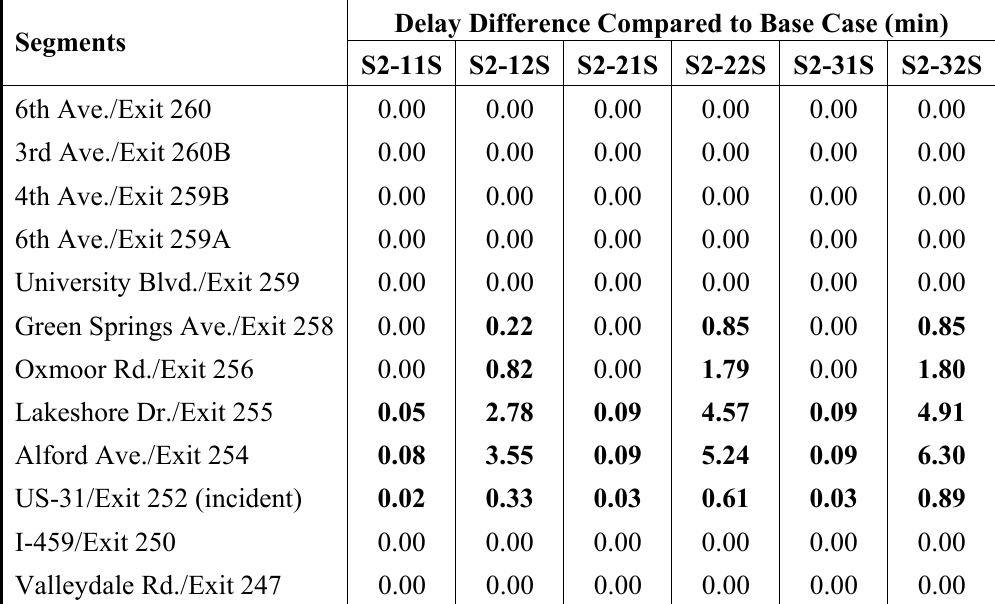
Table 7. Comparison of delay results without information provision